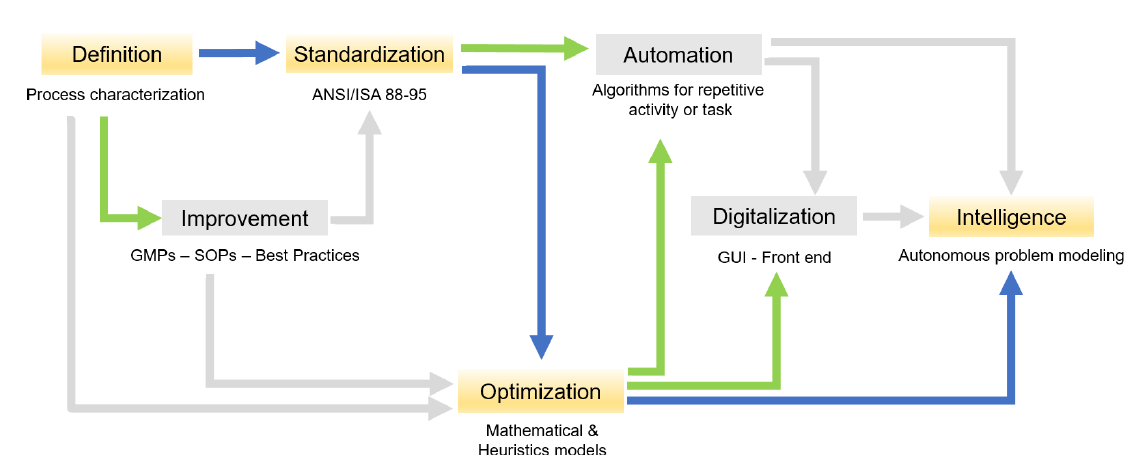
Figure 12. Potential activities derived from the case study, where GMPs refers to Good Manufacturing Practices, SOPs refers to Standard Operating Procedures, and GUI refers to Graphical User